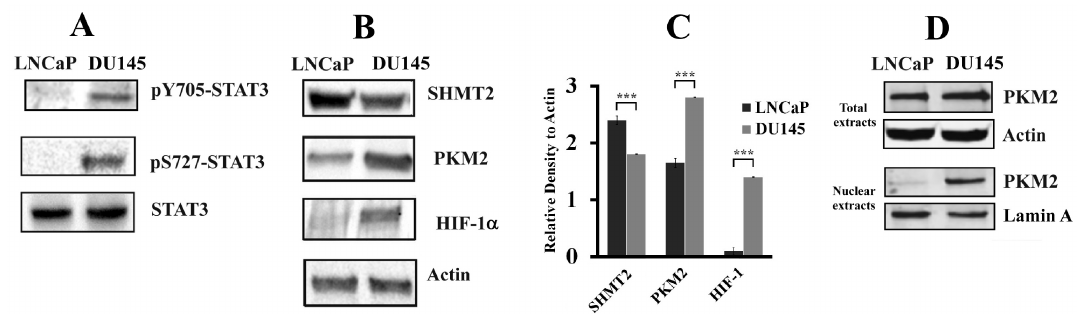
Figure 4. STAT3 PTMs, PKM2, HIF-1 α , and SHMT2 level in LNCaP and DU145 cell lines. ( A , B ) Western blot analysis of total protein extracts from LNCaP and DU145 cells. Samples were analyzed for STAT3 phosphorylation, both Y705 and S727 ( A ), and SHMT2, PKM2, and HIF-1 α amounts ( B ). The experiment was repeated three times and a representative blot image is shown. ( C ) Quantification by densitometric analysis of SHMT2, PKM2, and HIF-1 α immunoblots. For each sample, proteins were quantified and values normalized against the β -actin level presents in the same sample and taken as housekeeping control. Data were plotted as mean ± standard deviation (SD) of three separate experiments. Asterisks indicate significant differences in protein amount between the two cell lines (*** p < 0.001). ( D ) Western blotting analysis of total and nuclear protein extracts from LNCaP and DU145 cells analyzed for PKM2. Lamin was used as specific nuclear marker and normalization protein.